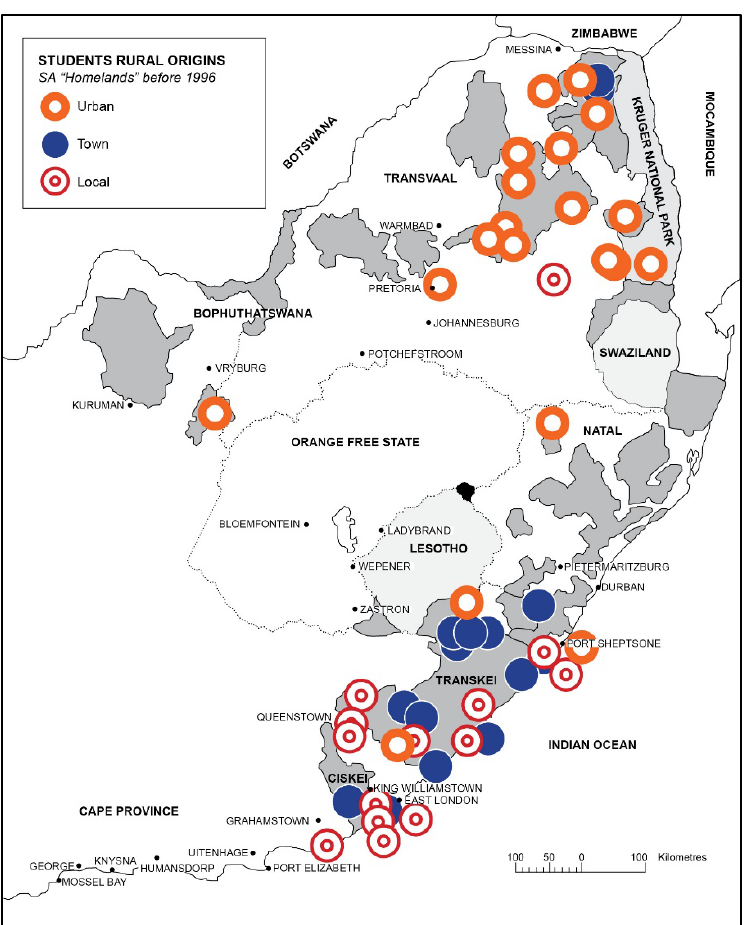
Figure 1: Stated co-researcher home locations by institution – circles can denote more than one